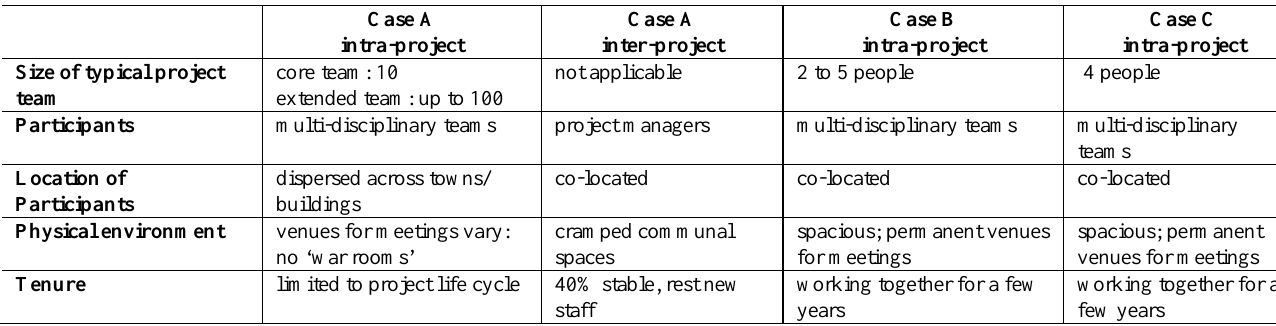
Table 1: Profiles of Cases A, B and